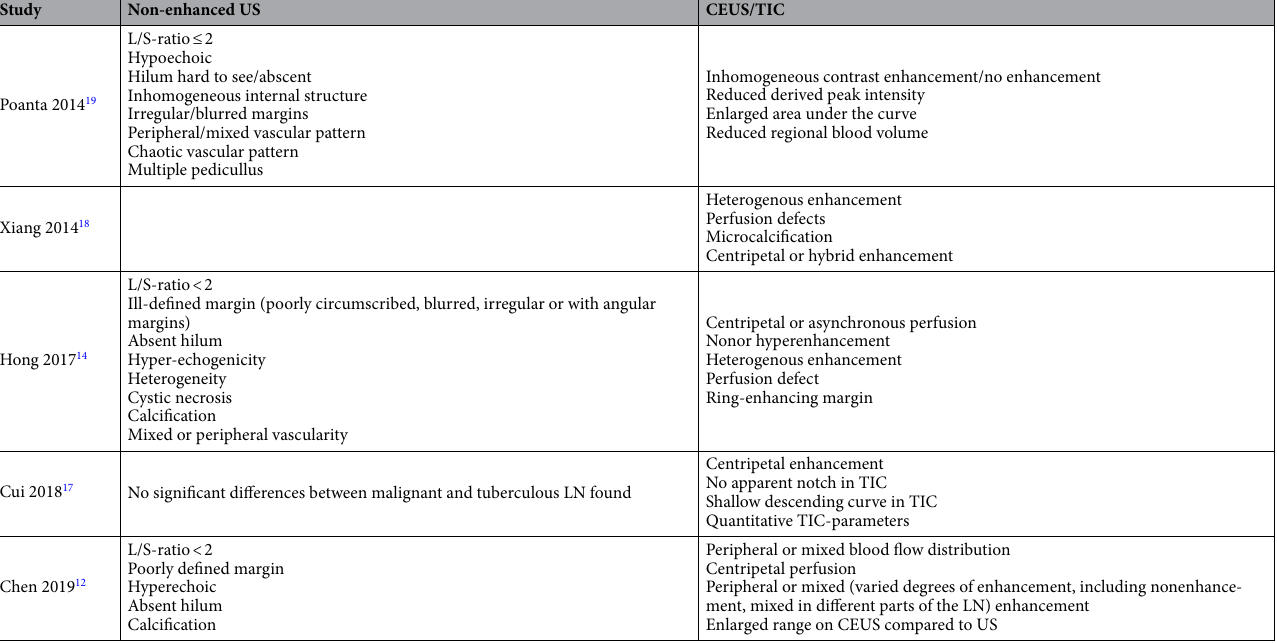
Table 4. Statistically significant features for malignant cervical lymph nodes found in the included studies. CEUS denotes contrast-enhanced ultrasound, L/S-ratio denotes the ratio of long- and short-axis diameter, TIC denotes time intensity curve, US denotes